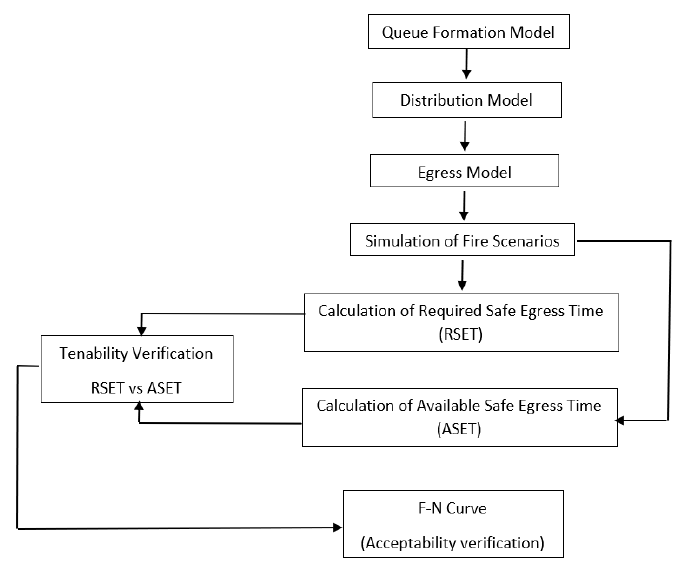
Figure 5. The process of quantitative consequence analysis model adopted from [24].